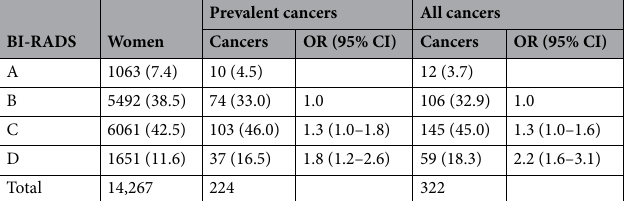
Table 3. Risk of prevalent and all cancers according to the breast density as evaluated by DSM in all three study centres.